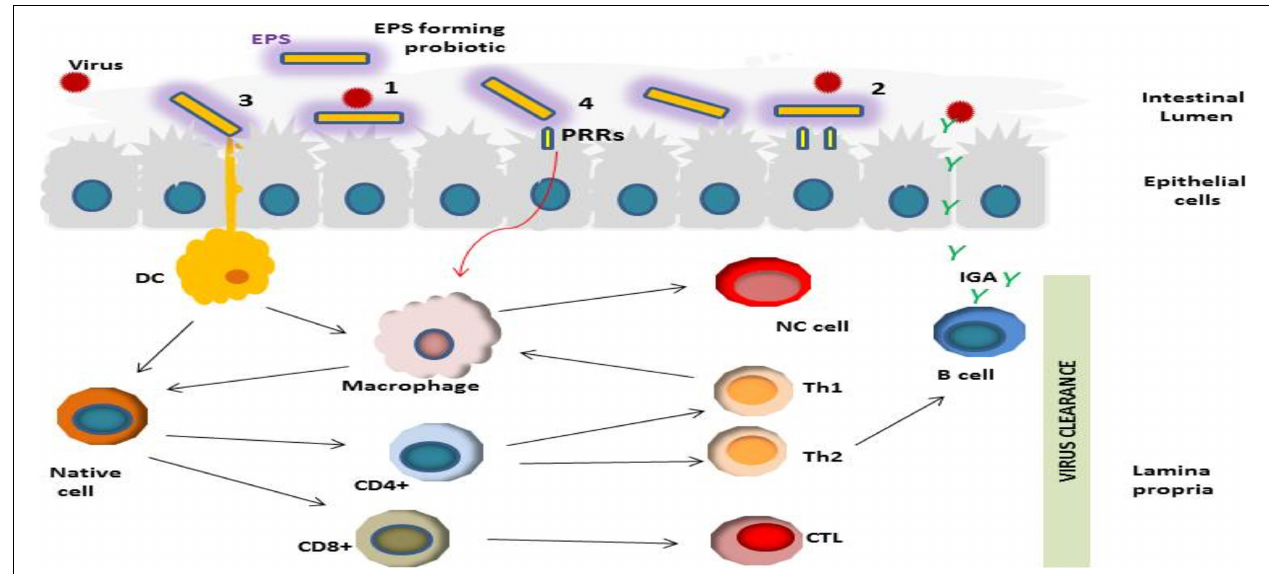
FIGURE 2 | Schematic representation of different potential antiviral activities of LAB-derived EPSs including; (1) Prevention of the viral infection through direct binding of viral particles; (2) Obstruction via shielding or masking virus pattern recognition receptor (PRRs) sites; (3) and (4) Stimulation of the immune response in mucosal epithelial and dendritic cells (DC) through their PRRs, resulting in induction of various cytokine production which consequently could modulate antiviral effects by activation of CD+ T lymphocyte differentiation into cytotoxic T lymphocytes; induction of macrophages, stimulation of antiviral activity via phagocytes by activation of Th1, induction of B cell proliferation and viral neutralization activity via secretion of antibodies.